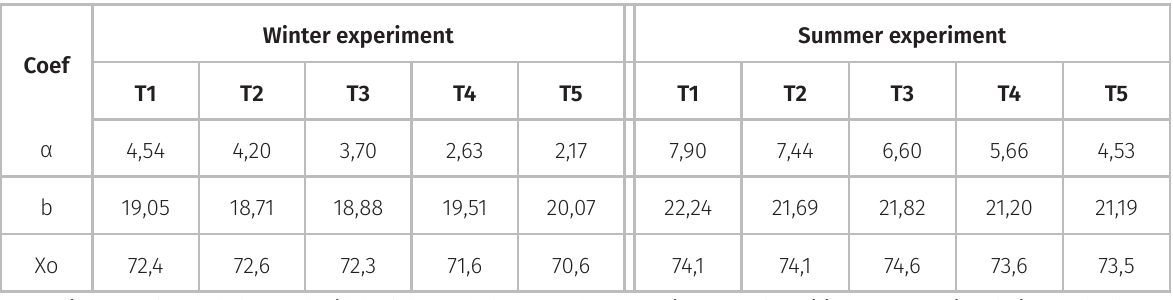
Table II. Parameters of the Gaussian Peak model, fitted to LAI data, for each of the treatments in the winter and summer experiments, for soybean